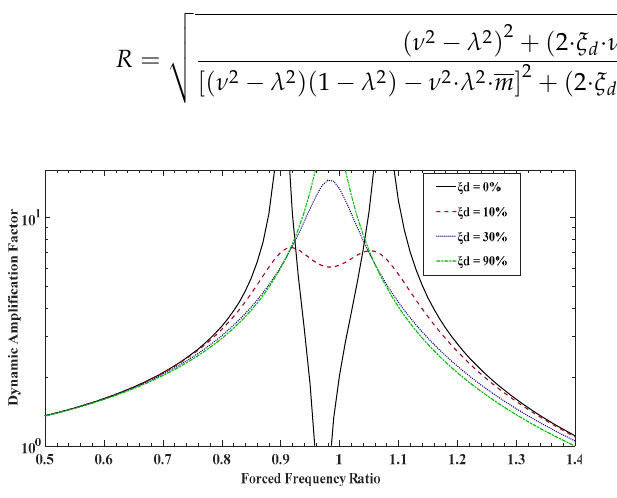
Figure 4. Dynamic amplification factor as a function of λ